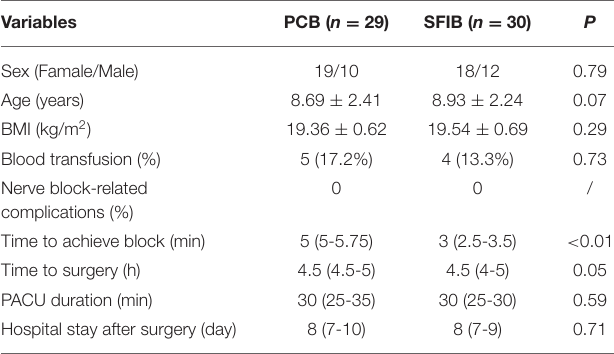
TABLE 1 | Demographic characteristics.